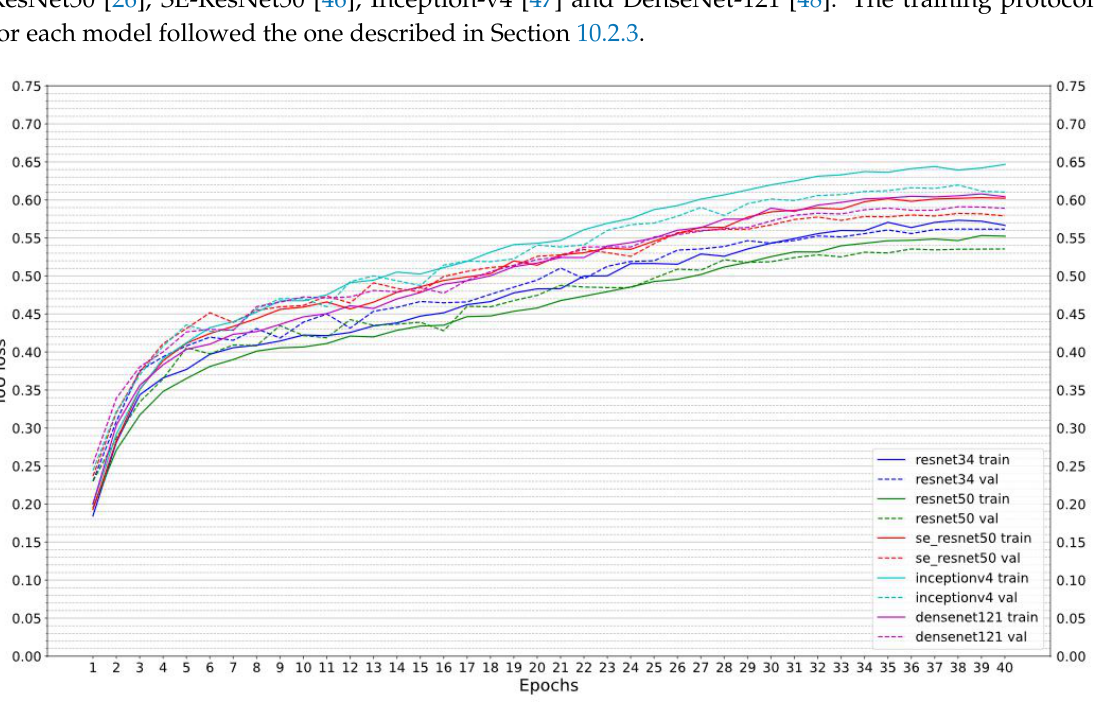
Figure 15. Defect Segmentation Network (DSN) results for different encoder architectures over 40 epochs trained on the 200 orthoframe dataset. Performed with 2-fold cross-validation.